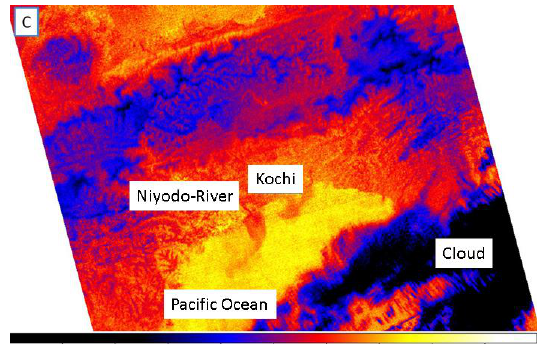
Figure 9. Zoom of the region C from